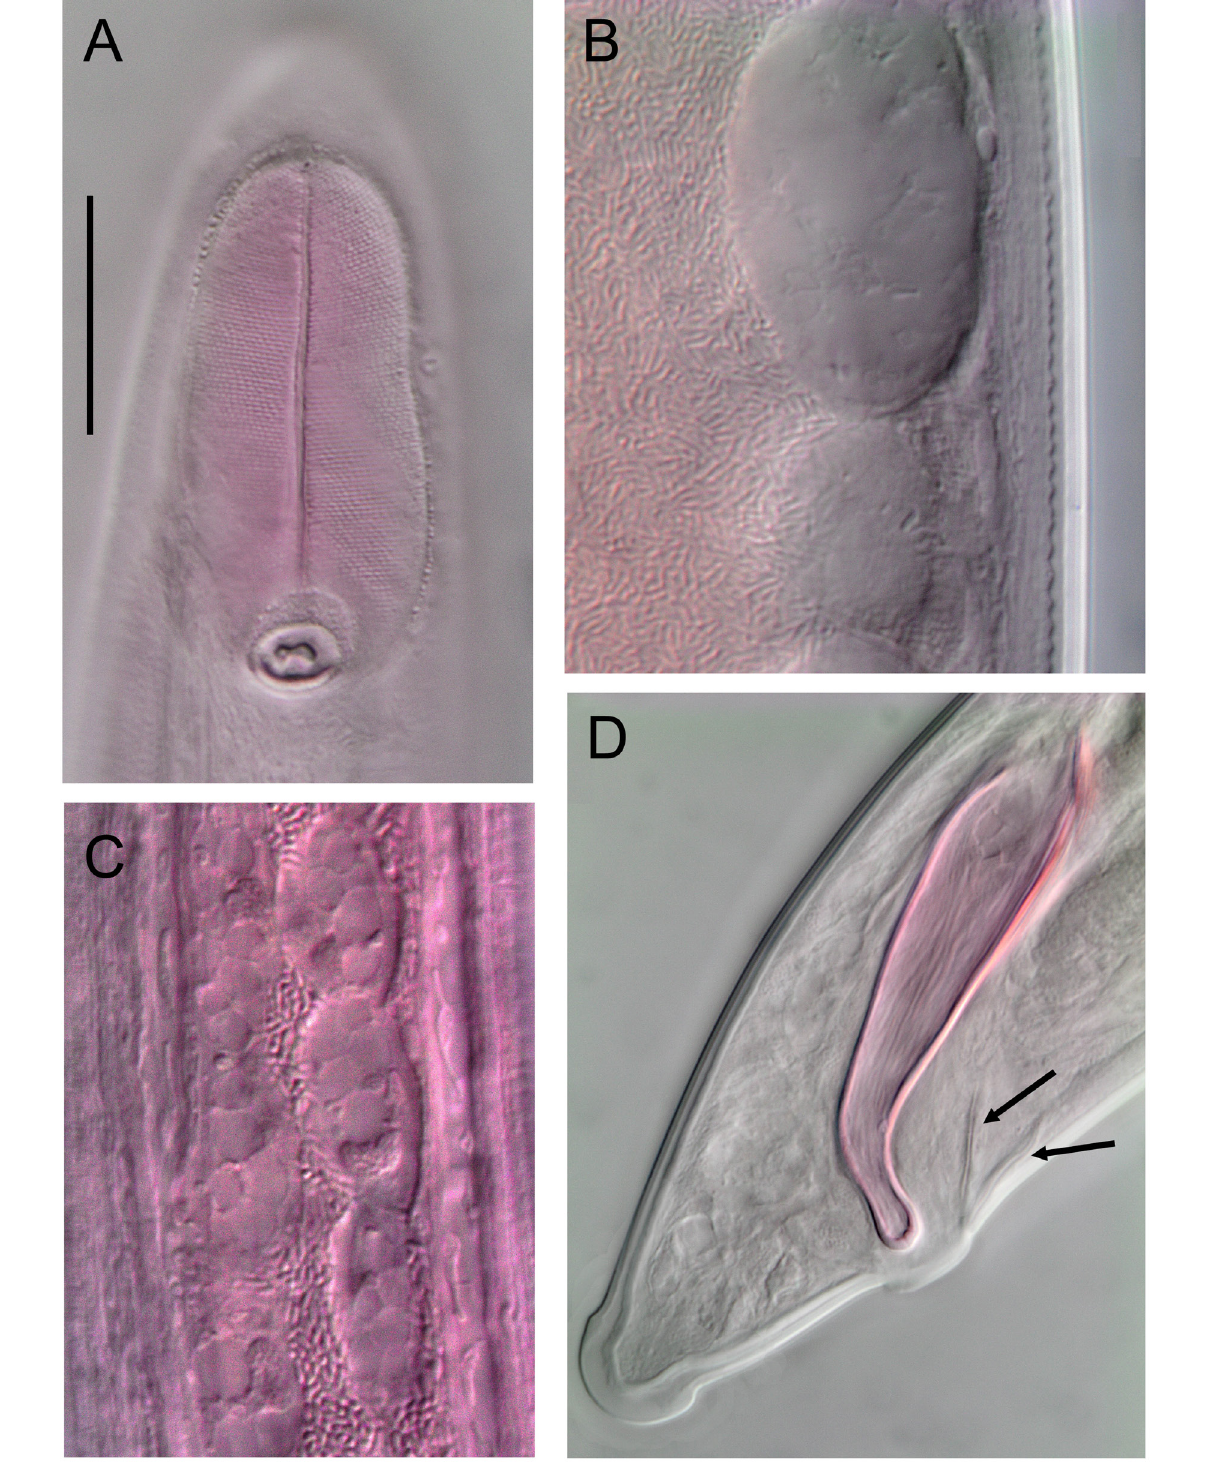
Fig. 2. Rhaptothyreus typicus Hope & Murphy, 1969. Light micrographs (♂ ). A . Lateral view of head showing amphid. B . Mid-body region showing cuticle, turgescent cells and portion of anterior tropho- some with rod-shaped structures. C . Cells of lateral chord with clear, round inclusions. D . Posterior body region. Arrows show the position of the two small ducts apparently joining just prior to the cloacal opening. Scale bar: A, C = 20 µm, B = 18 µm, C = 30